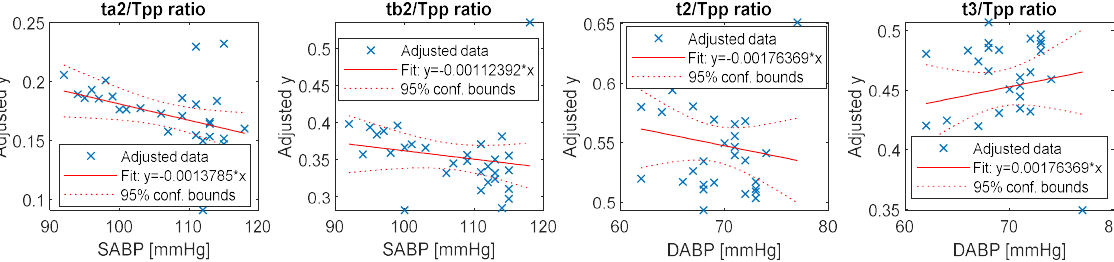
Figure 2. Examples of fitted linear relations between PPG WF parameters and SABP/DABP values calculated with the linear regression approach for (from left to right): ta2/ T pp ratio, tb2/ T pp ratio for estimation of SABP values and t2/ T pp, t3/ T pp ratios for DABP estimation.